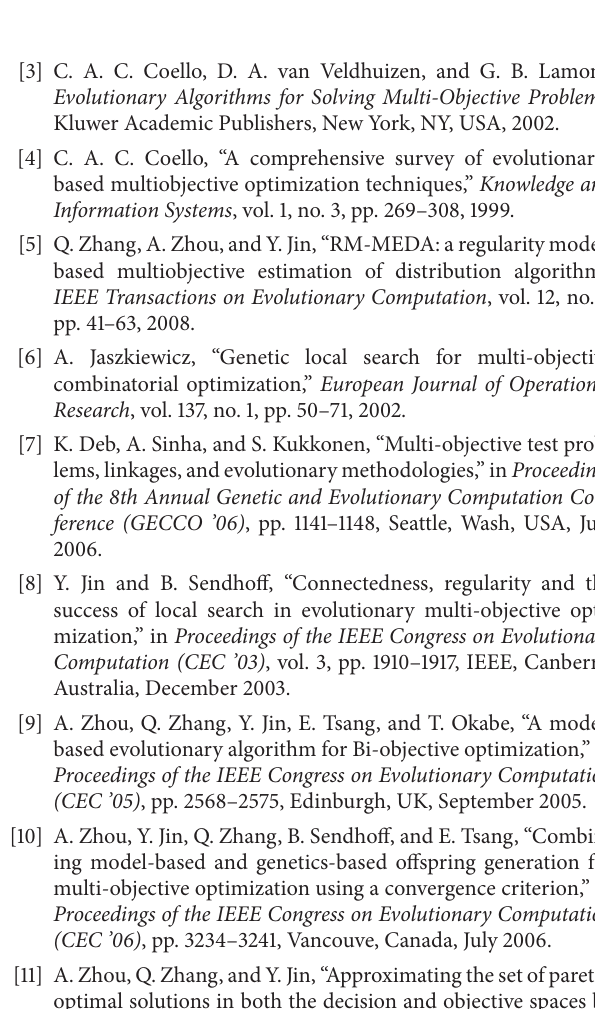
Figure 10: The final nondominated solutions and fronts found by NSGA-II. (a) The result with the lowest 𝛾 -metric and (b) all the 10 fronts in 10